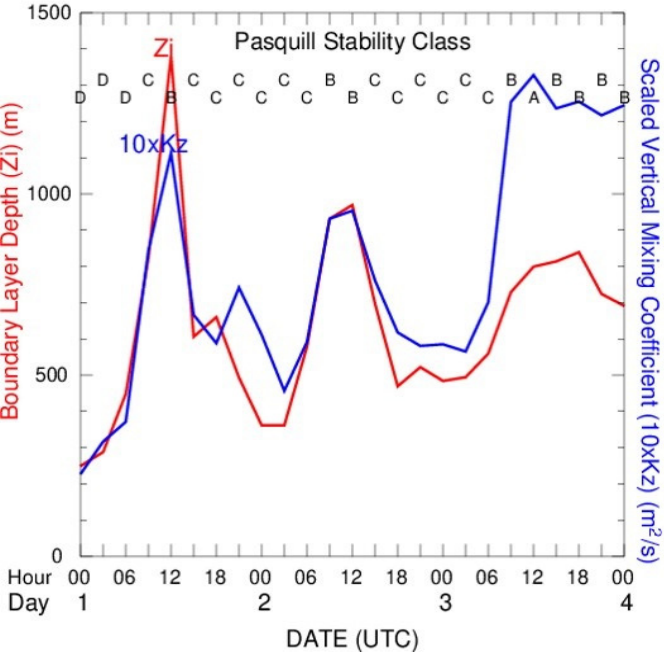
Figure 1. Atmospheric conditions during smoke event days.